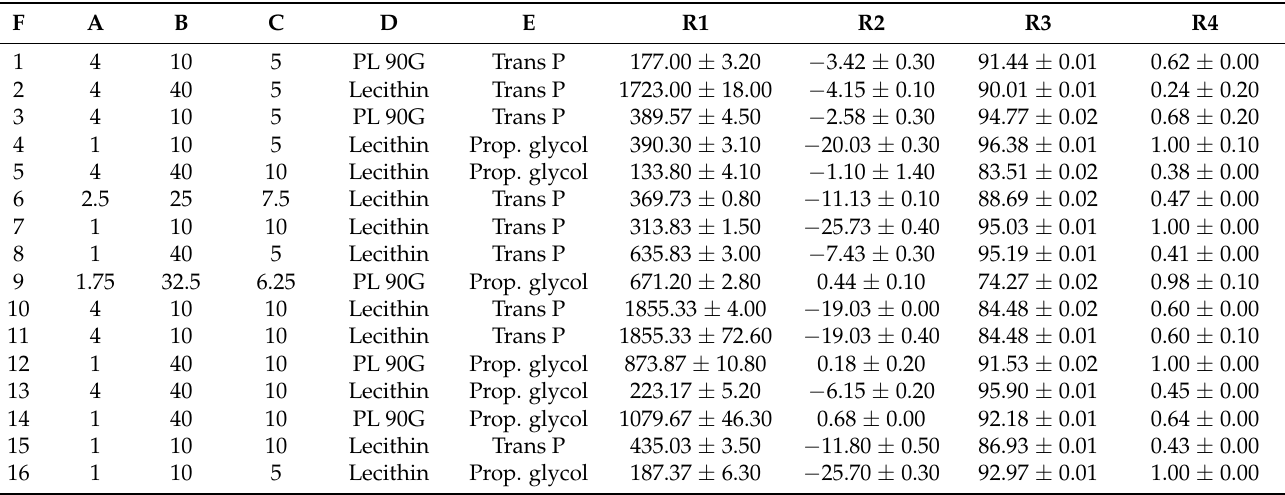
Table 2. The screening formulation parameters for the 16 formulations, with five factors, multiple levels, and measured responses.